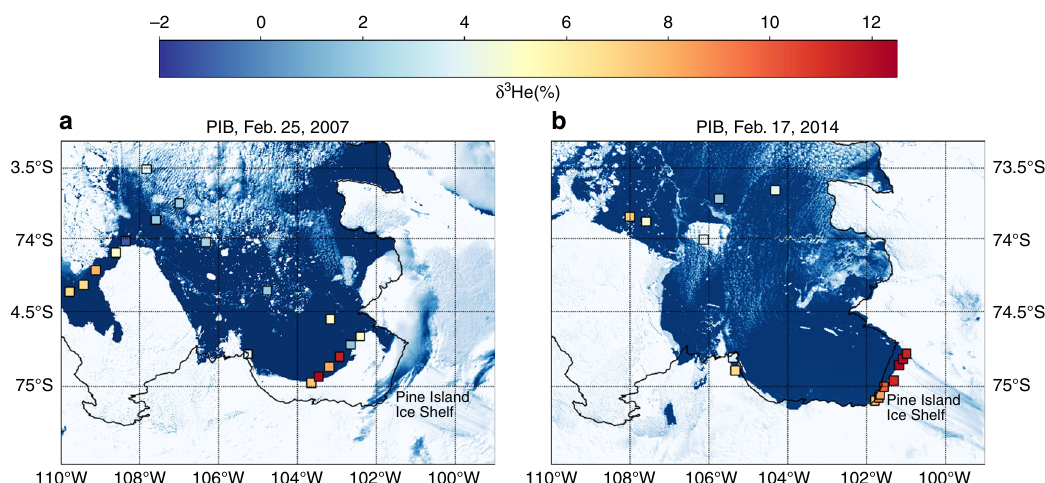
Fig. 3 Map of elevated 3 He samples from 2007 and 2014 in Pine Island Bay. MODIS images of Pine Island Bay on a 25 February 2007 and b 17 February 2014. In 2007, fast ice precluded sampling directly at the front of the ice shelf cavity. The colored squares depict the maximum value of δ 3 He in the top 300 m of the water